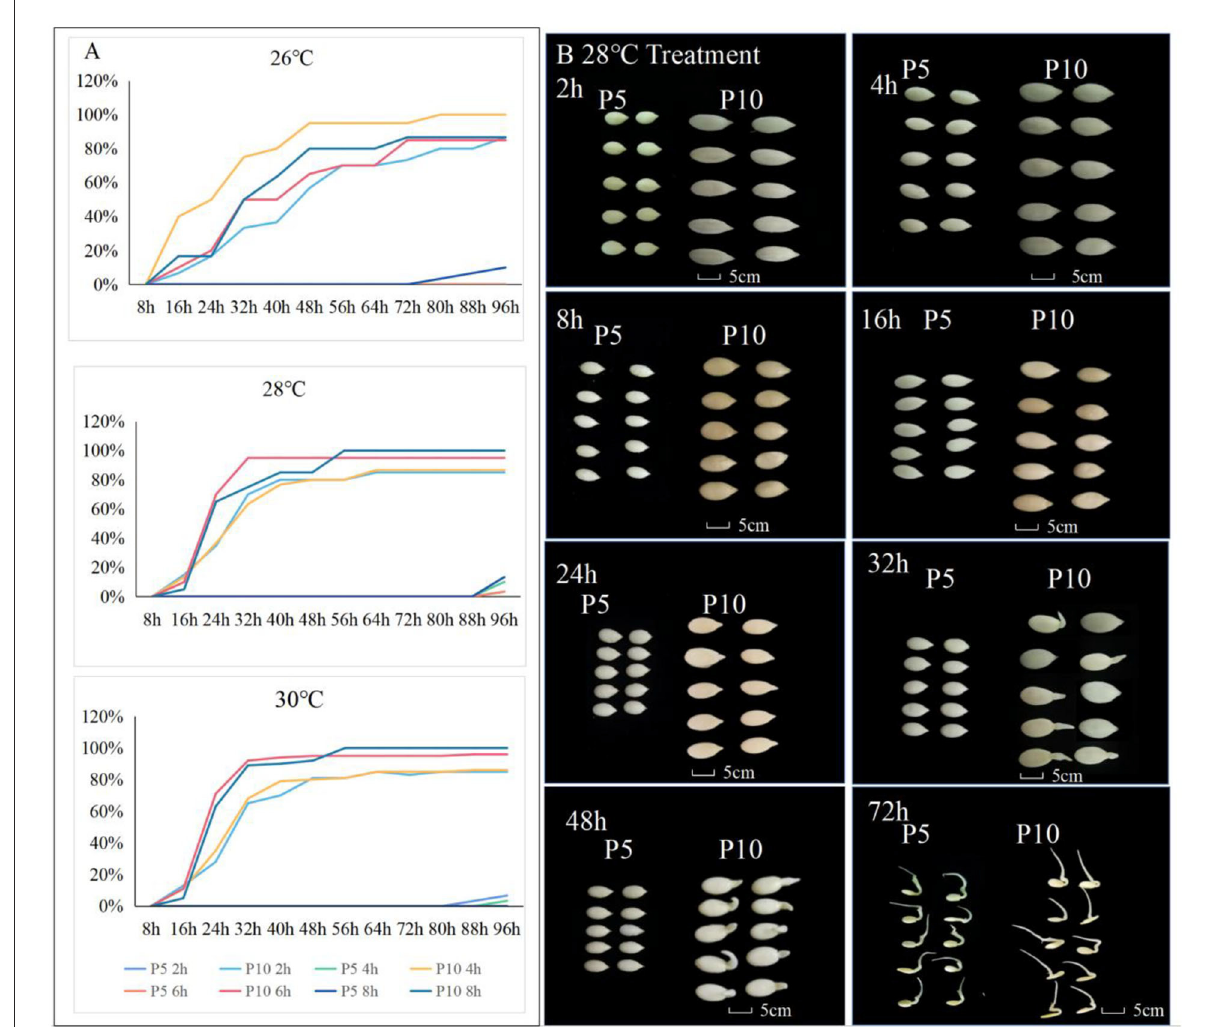
FIGURE1 Seed germination performance for different treatments of germination temperature with soaking time in P5 and P10. (A) The dynamics of germination rate from 16 to 96h after germination was investigated for the seed soaking time of 2, 4, 6, and 8h with 26, 28, and 30 ◦ C germinate temperatures of parental lines. (B) The seed germination of P5 and P10 under the treatment with a soaking time of 8, germinate temperature of 28h, and the investigated seed germination time from 2 to